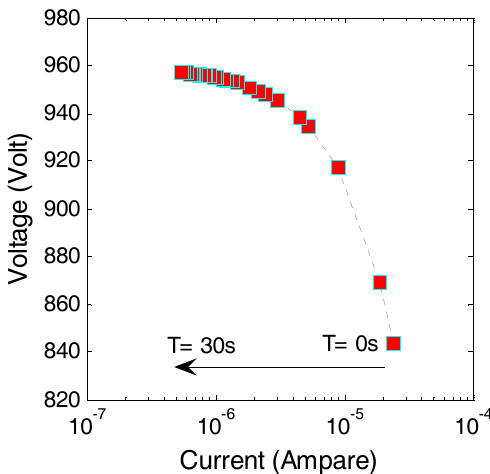
Figure 5. DC (time averaged) current and voltage plots by sampling every 0.5 s for 30 s in total at the electrode gap distance of 150 μ m and at a continuous source voltage of 1000 V.